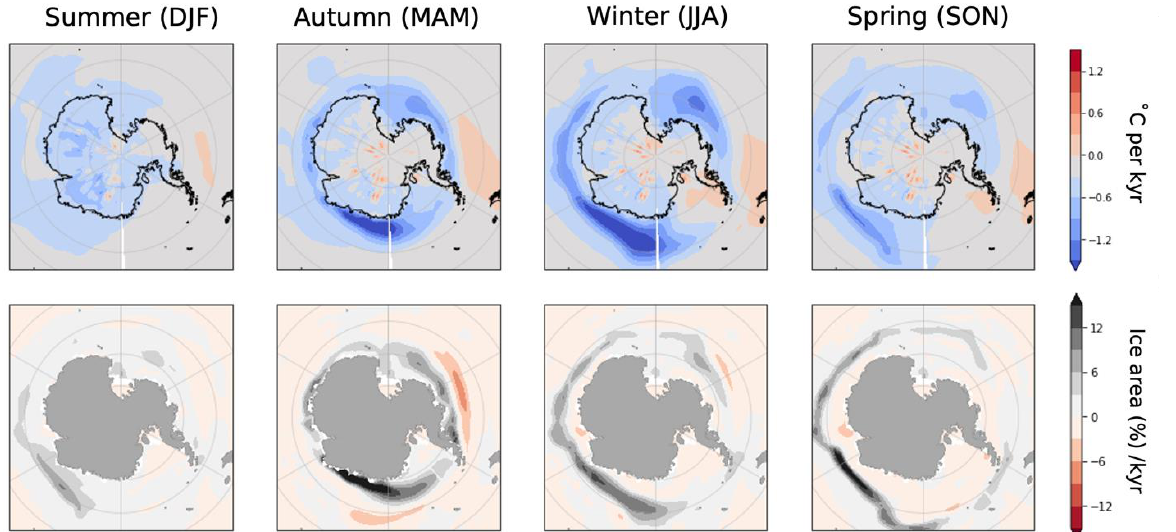
Figure 7. Seasonal temperature (°C per kyr) and sea ice concentration trends (ice area % per kyr) in the full forcing ensemble mean.